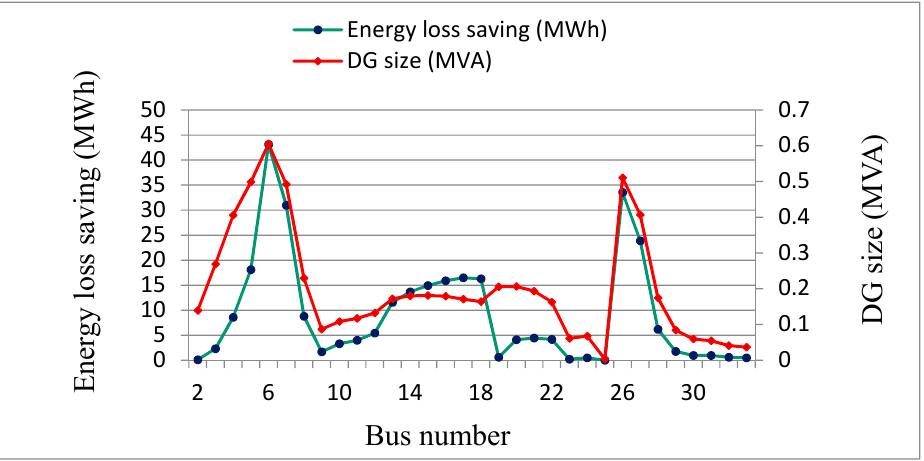
Figure 17. DG sizes (in MVA) and energy loss saving (in MWh) with DG units are placed at nodes 6, 31 and 25 for IEEE 33-bus system.